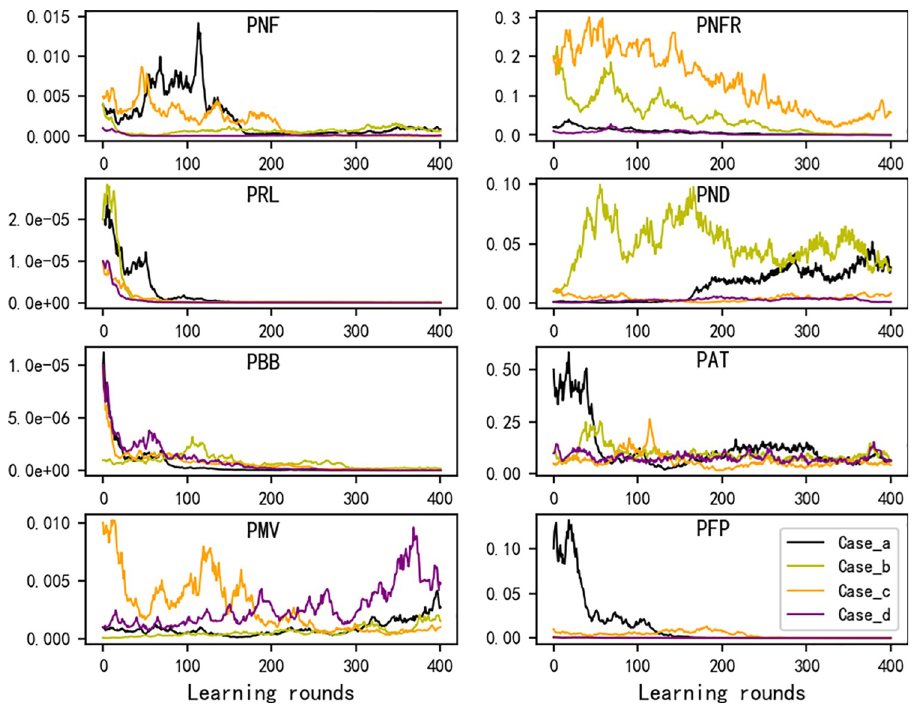
Fig 3. The automatic parameter-adjustment during the parameter-exploration in principle of machine-learning. The parameter-adjustment tendency of the four cases with the learning rate of 0.2 in Fig 2A–2D (i.e., represented by the red lines within the subfigures in Fig 2) are shown here in different colors (the legend in the lower right subfigure applies to the whole figure). The vertical axis of a subfigure represents the value of the corresponding parameter whose name is shown within the panel (in the PFP subfigure, the Case_b line is covered by the Case_d line). Note that the eight probabilities are in practice adjusted simultaneously in a learning round (see Methods).